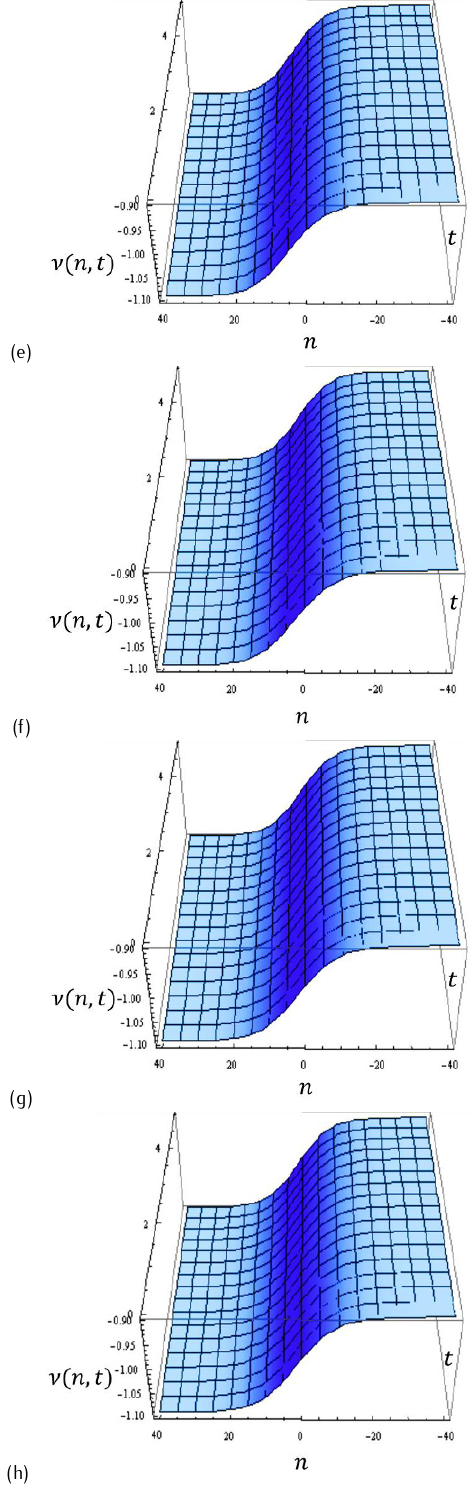
( n,t ) as in Eq , λ = 1 ; (c) µ = 1 , Figure 6. Explicit numerical solutions of Eq. (17) for ν 2 2 3